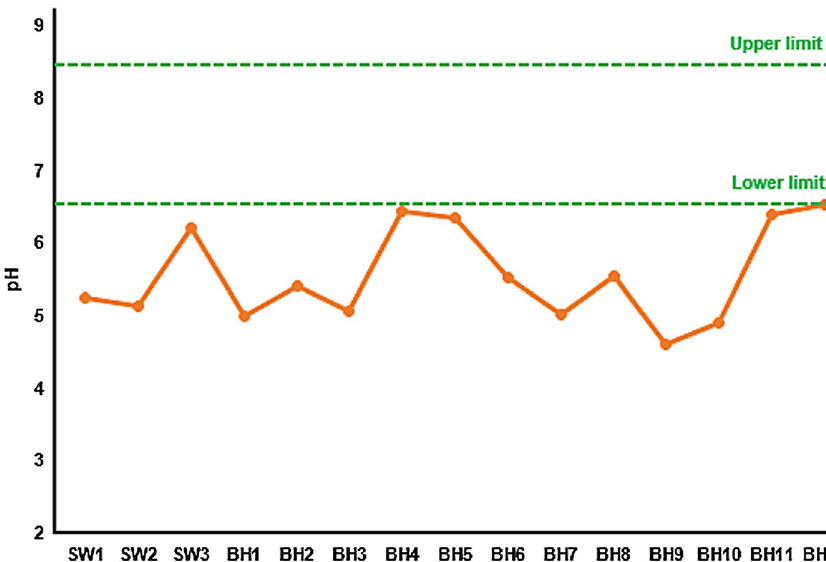
Fig. 2 pH values of the samples graphically compared to the WHO (2017) and NIS (2007) limits